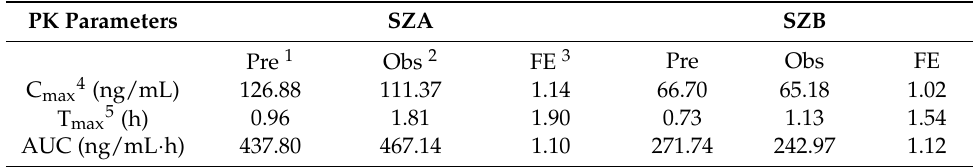
Table 1. Predicted and observed values for pharmacokinetic parameters of SZA and SZB. Table 1 . Predicted and observed values for pharmacokinetic parameters of SZA and SZB .